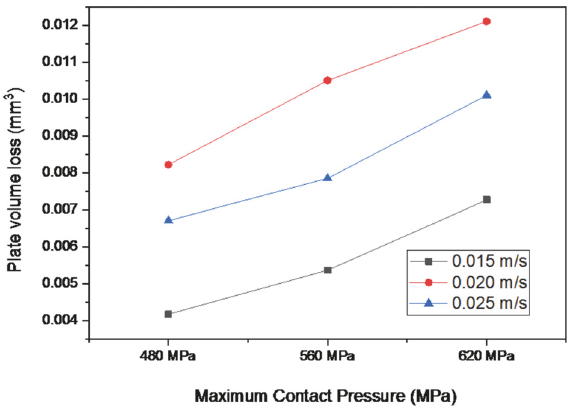
Figure 4: Variation of volume loss of zircaloy-4 plate with contact pressure and sliding speed.